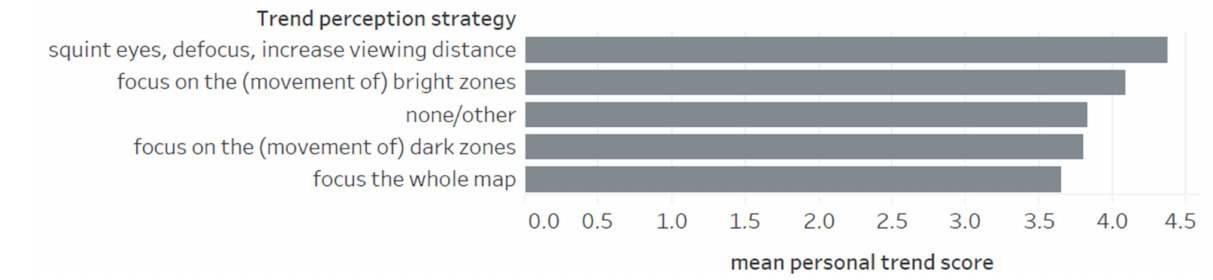
Figure 14. Performance of strategies for trend perception.